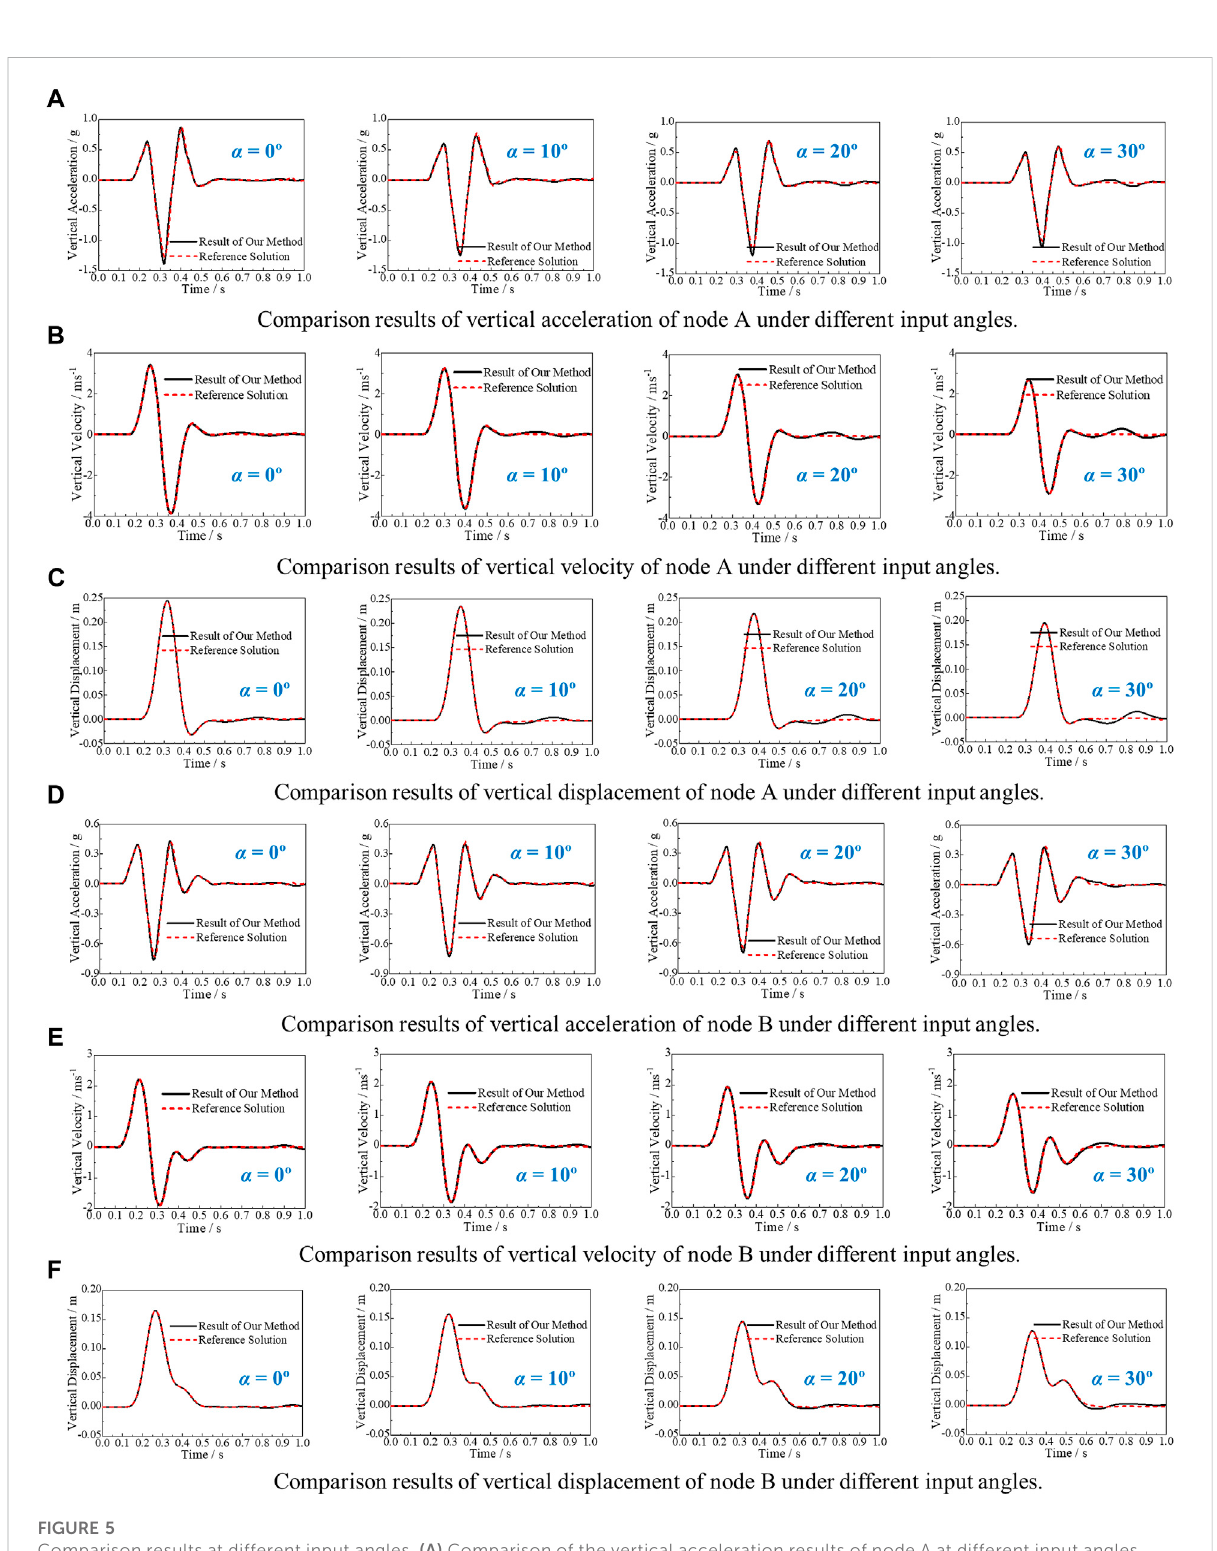
FIGURE 5 Comparison results at different input angles. (A) Comparison of the vertical acceleration results of node A at different input angles. (B) Comparison of the vertical velocity results of node A at different input angles. (C) Comparison of the vertical displacement results of node A at different input angles. (D) Comparison of the vertical acceleration results of node B at different input angles. (E) Comparison of the vertical velocity results of node B at different input angles. (F) Comparison of the vertical displacement results of node B at different input